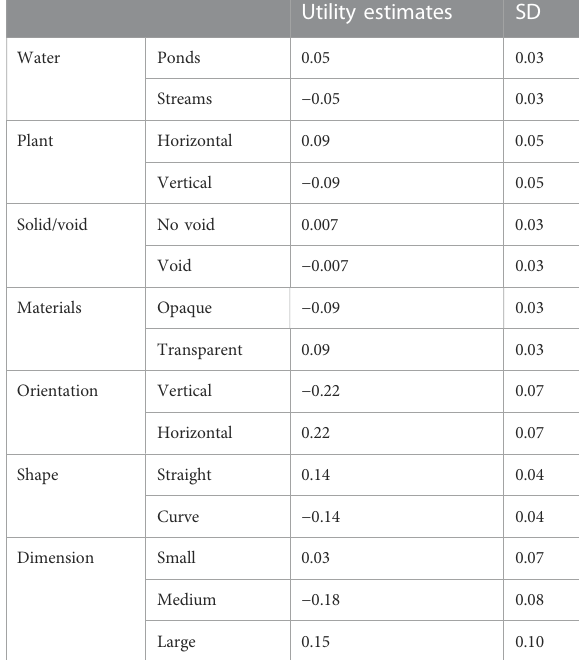
TABLE 1 Total part worth